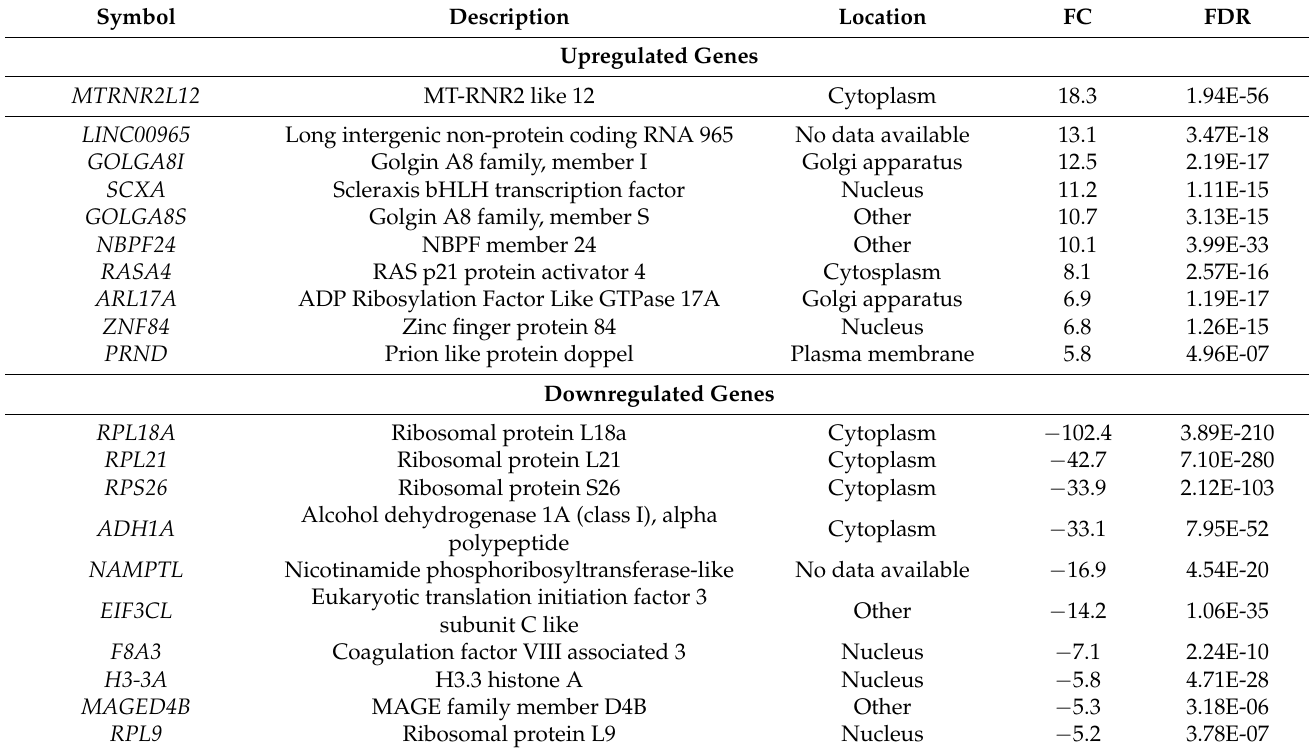
Table 2. Top 10 up- and downregulated genes in MFS compared with